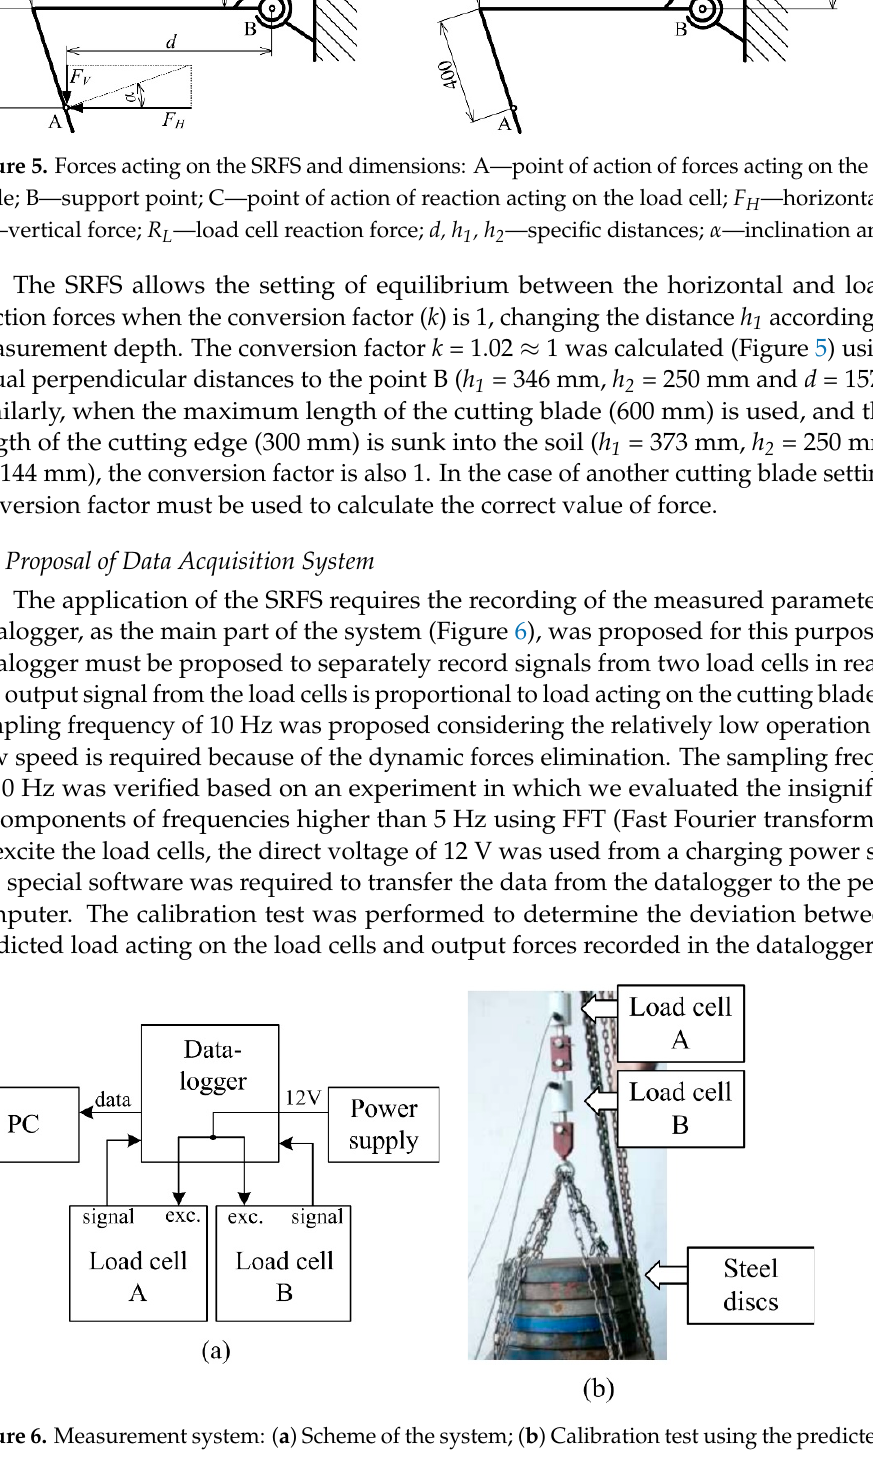
Figure 6. Measurement system: ( a ) Scheme of the system; ( b ) Calibration test using the predicted load.